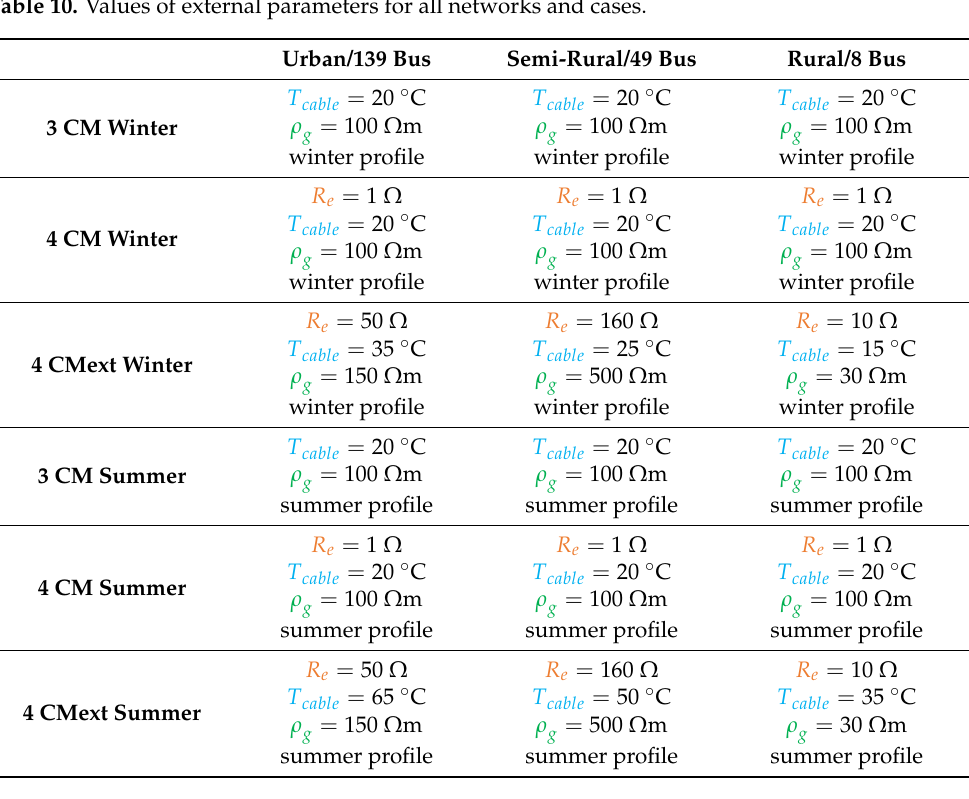
Figure 15. Load power at selected instants for the summer and winter profiles. Load power in pu is given relative to the maximum power of the load. Table 10. Values of external parameters for all networks and